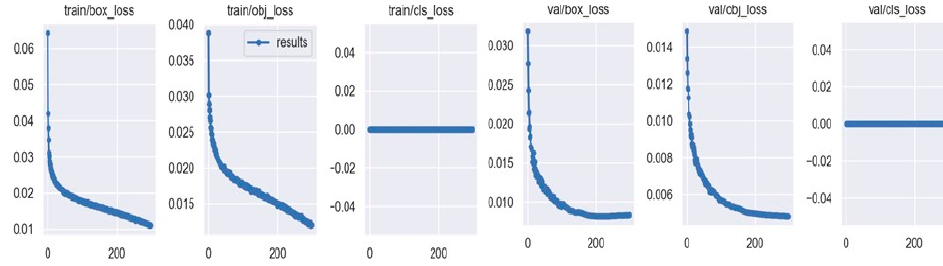
Figure 6. Loss curve during training and validation.